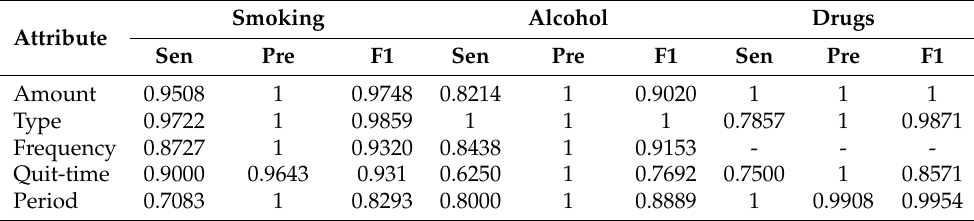
Table 10. Attribute extraction performance on the MTSamples